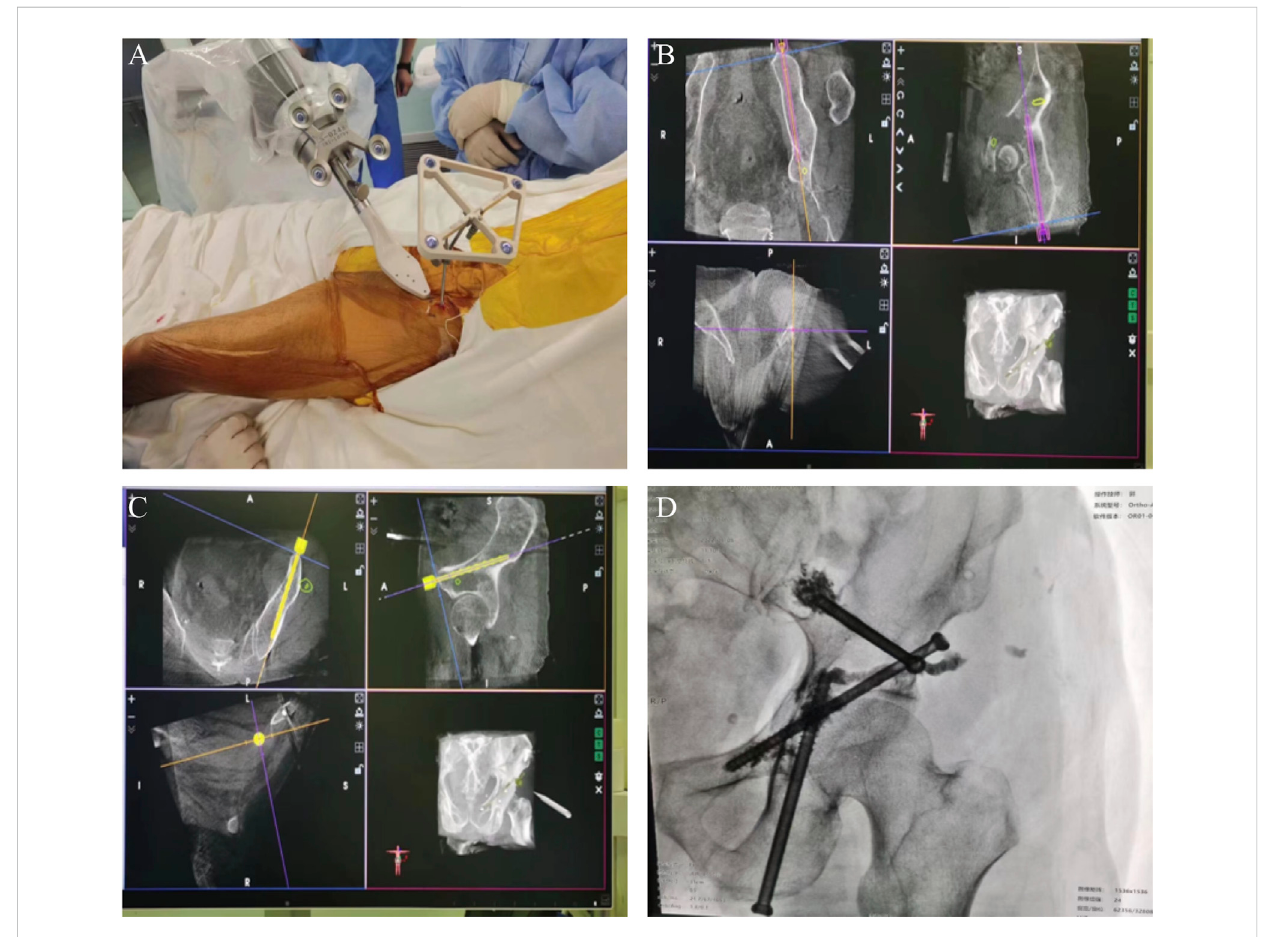
FIGURE 2 Intraoperative orthopedic robot for accurate positioning and imaging at the completion of surgery. (A – C) Accurately located screw channels with the help of orthopedic robot (D) X-ray radiographs of screw fi xation and cement fi lling when the surgery was completed.